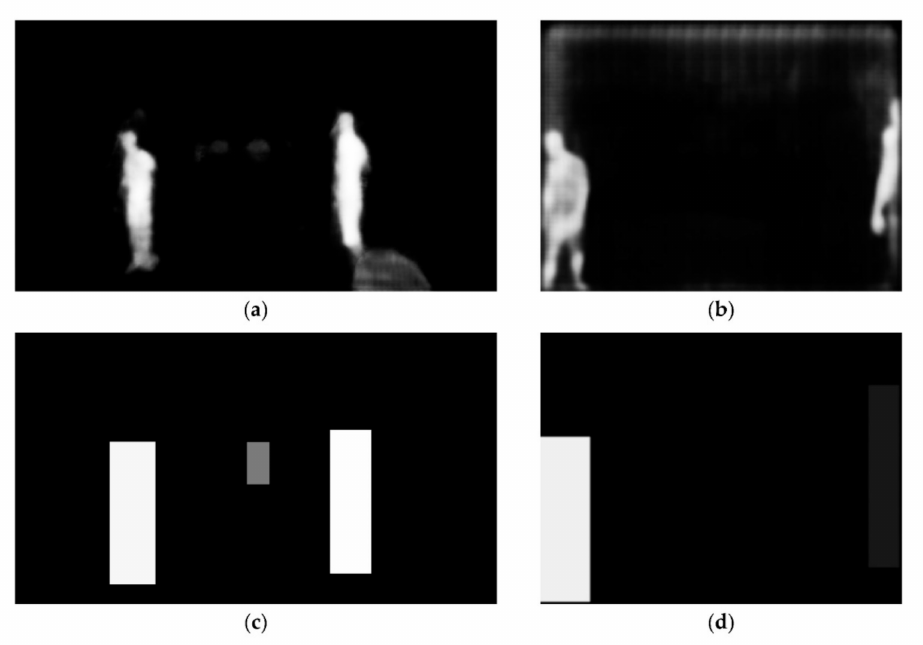
Figure 8. Gray scale image masks. ( a ) RGB 3 and expert E B − RGB ; ( b ) T 5 and expert E B − Thermal ;